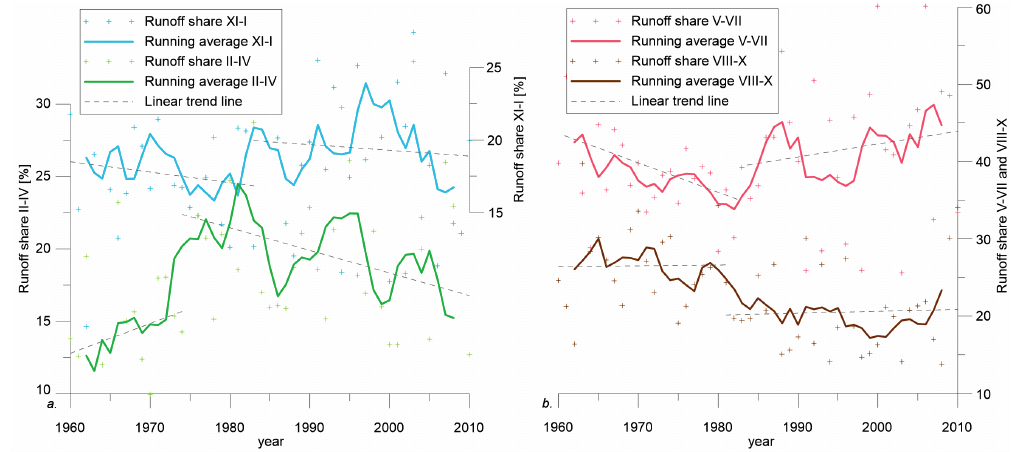
Figure 8. Changes in seasonal distribution of runoff in period 1961–2010 expressed as shares of the total yearly balance: ( a ) shares of winter (XI-I) and spring (II-V); and ( b ) shares of summer (V-VII) and fall (VIII-X). The trend lines are based on results